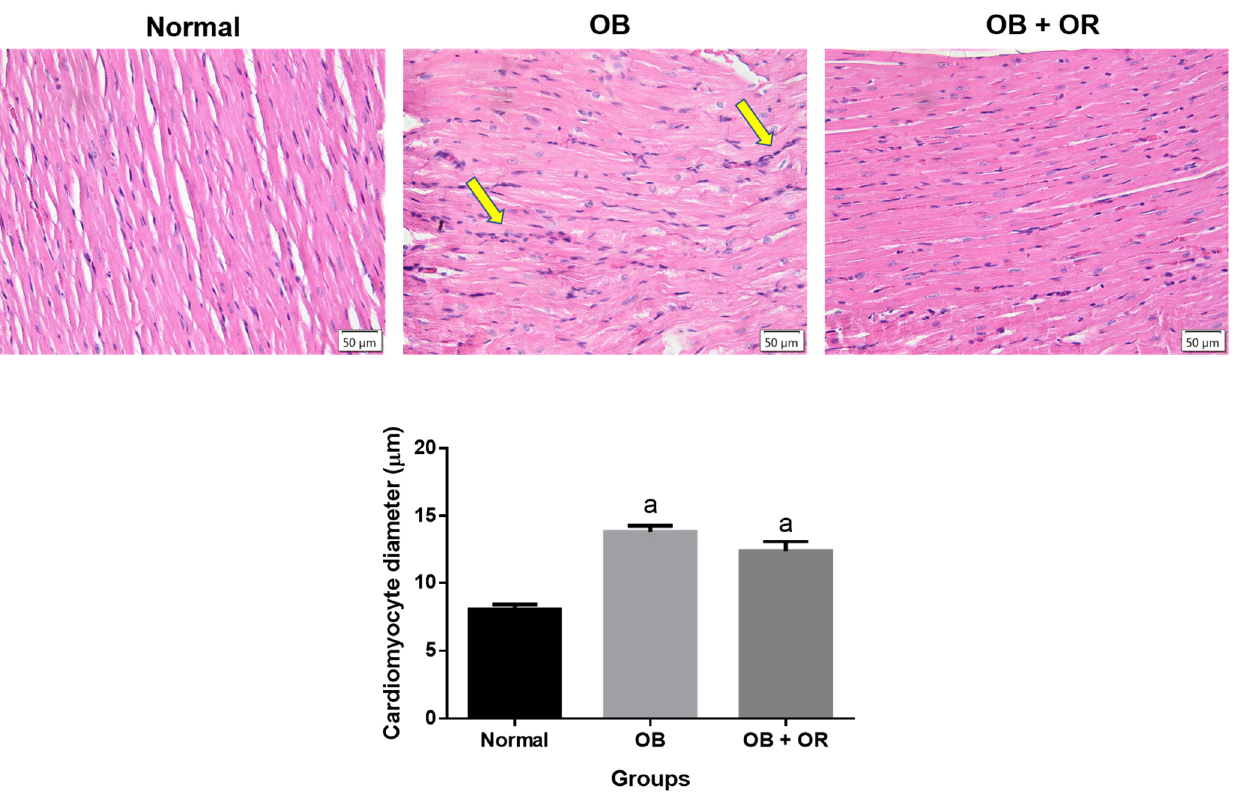
Figure 6. Representative images of H&E-stained left ventricle in longitudinal sections in Normal, OB (Obese control), and OB + OR (obese and orlistat 10 mg/kg/day) groups (magnification × 400, scale bar = 50 µ m). Normal group revealed a normal architecture of cardiomyocyte cells which were lined in homogenous pattern. The OB and OB + OR groups exhibited significant increases of cardiomyocyte diameter when compared to Normal group in conjunction with high infiltration of inflammatory cells in OB group (yellow arrow). a p < 0.05 compared with Normal group. Data were analyzed by One-way ANOVA followed by Tukey’s post-hoc test.